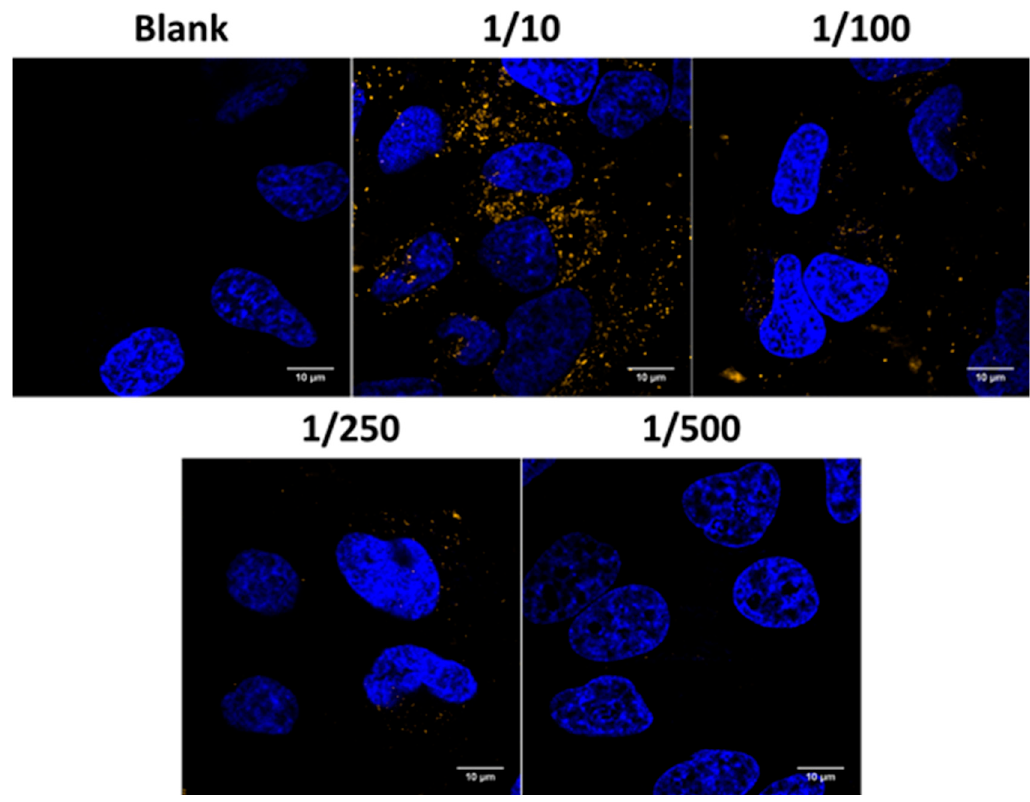
Figure 6. Evaluation of the uptake of JetPEI/pDNA/AuNP complexes in Hela cells. Confocal microscopy images show nuclei stained with Hoechst in the blue channel and AuNP core in the orange channel. The scale bar represents 10 μ m.